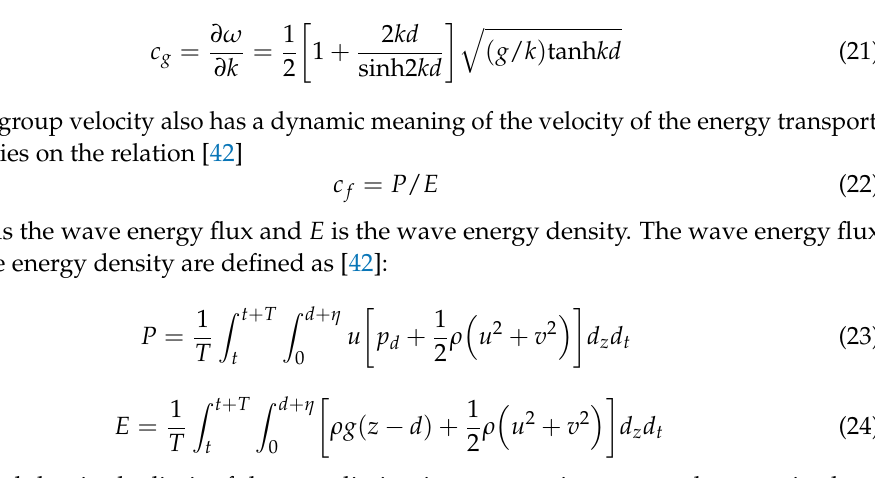
( b ) Figure 8. The velocity of the energy transport at different resonator lengths. ( a ) 𝑆 𝐿⁄ = 0.75 . ( b ) 𝑆 𝐿⁄ = 1.0 .